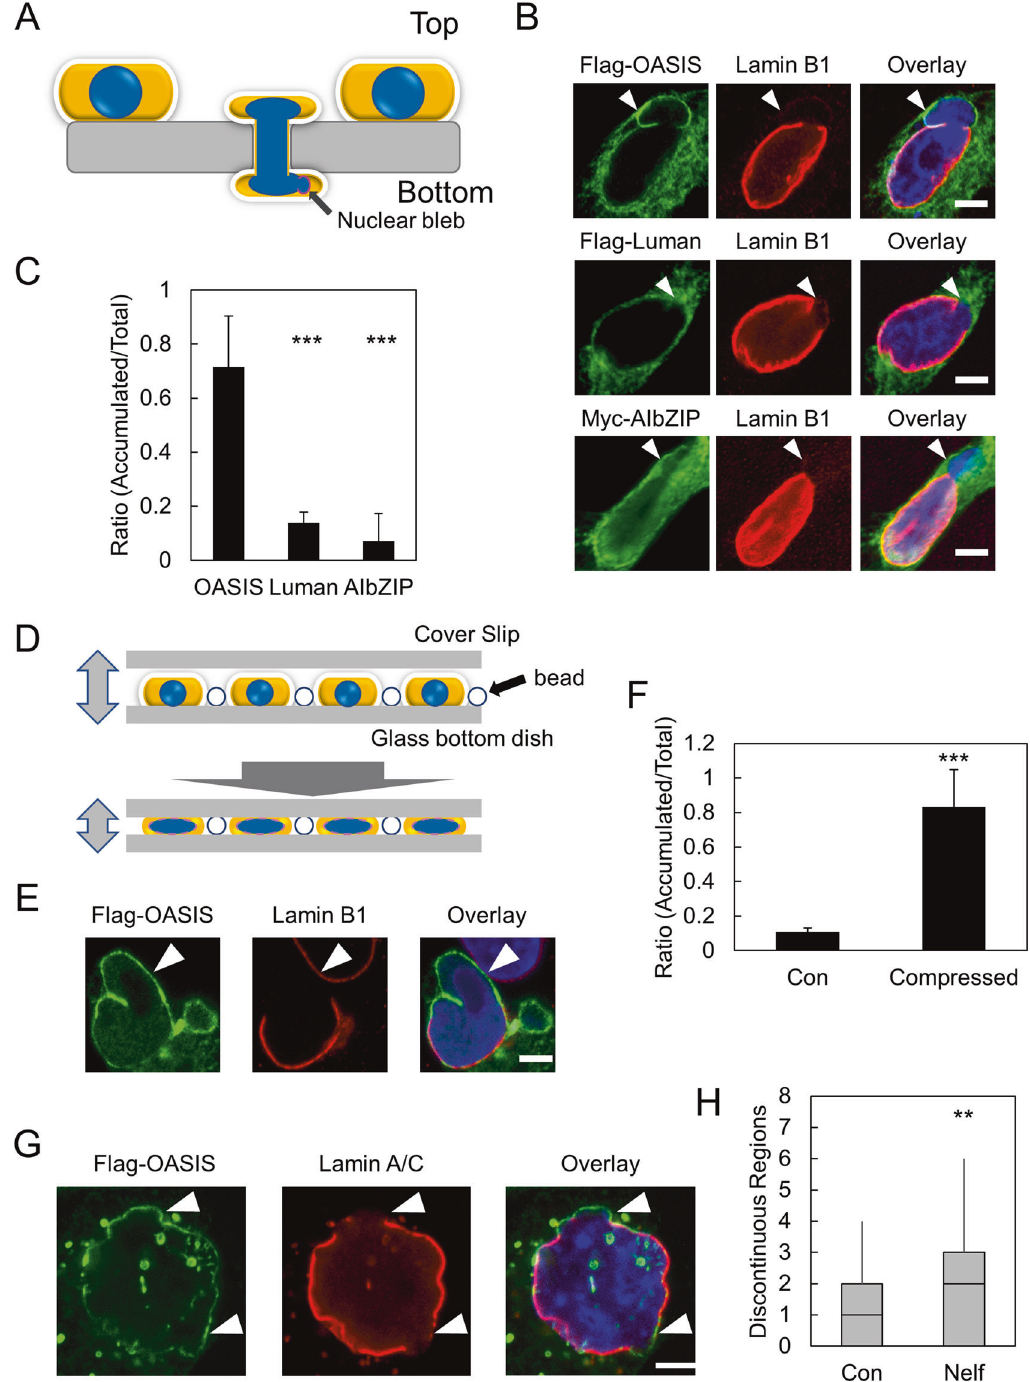
A subgroup of INM proteins named the LEM domain proteins share a conserved motif that is exposed to the nucleoplasm [28]. LEM domains of these proteins interact with BAF, a chromatin binding protein [29]. Recently, it has been demonstrated that BAF and LEM domain proteins target ESCRT III complex to ruptured NE sites, where it is proposed to assist in membrane resealing [14 – 17]. To test whether these factors colocalize with OASIS at nuclear blebs, the expression vectors of GFP-BAF, LAP2 β -GFP, GFP-MAN1, and GFP-CHMP7 were co-transfected with that of Flag-OASIS into shLMNB1 cells. We found that GFP-BAF colocalized with OASIS